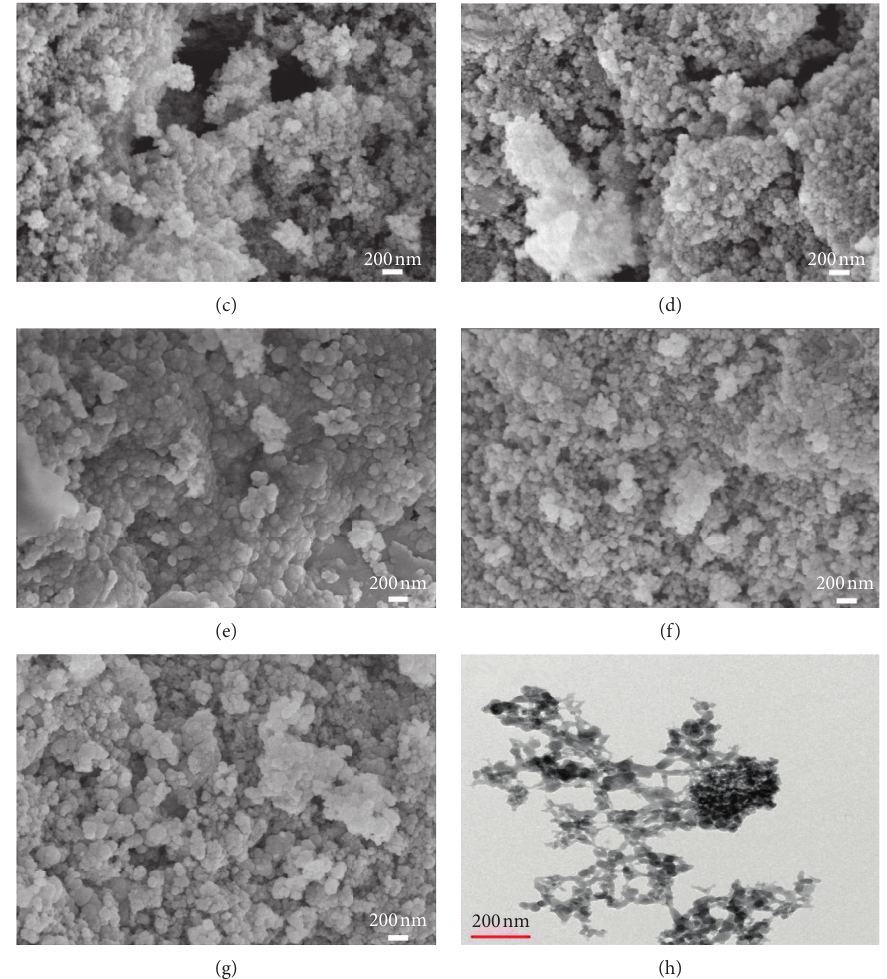
Figure 3: Micrograms of CH precipitates. SEM images of (a) TA0, (b) TA01, (c) TA03, (d) TA05, (e) TA1, (f) TA3, and (g) TA5 and (h) TEM image of